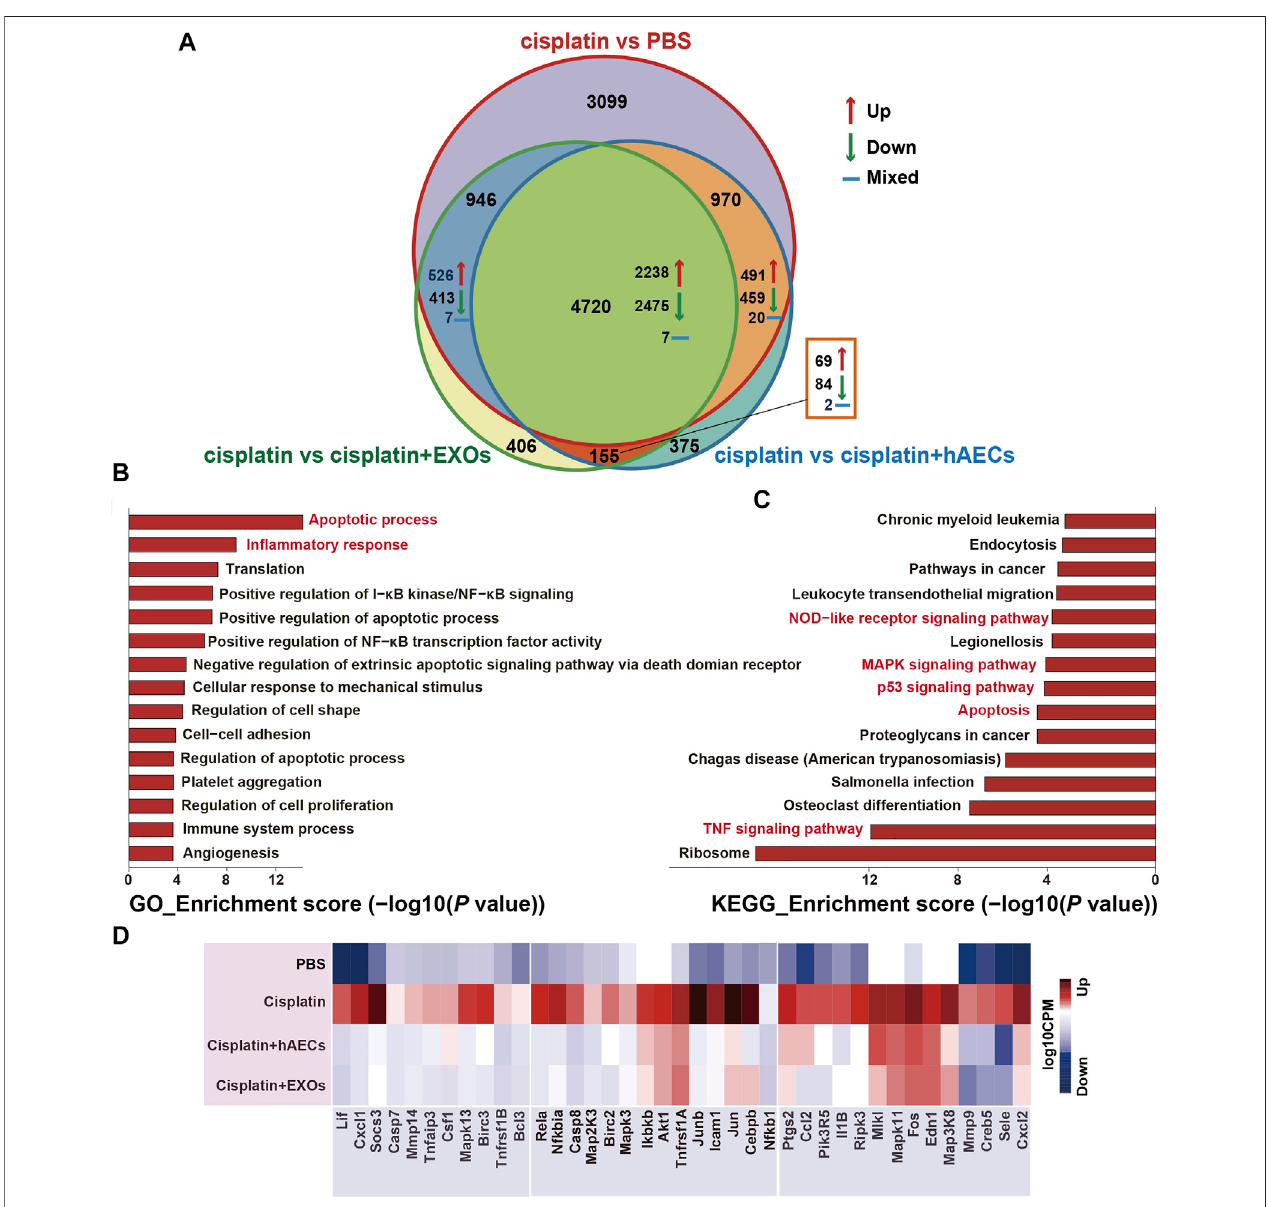
FIGURE2| RNAsequencinganalysisofkidneysfromC57BL/6Jmicetreatedwith15 mg/kgcisplatin. (A) Venndiagramshowingthenumbersofsigni fi cantDEGs across the four indicated groups. (B,C) The top 15 enriched GO terms and KEGG pathways of the 2,238 DEGs. (D) Heatmap showing the TNF pathway-related DEGs differentially expressed across the four groups. The colors indicate the value oflog10 CPM. CPM, counts per million; cisplatin, Cis-diamminedichloroplatinum (II); DEGs, differentially expressed genes; GO, Gene Ontology; KEGG, Kyoto Encyclopedia of Genes and Genomes.